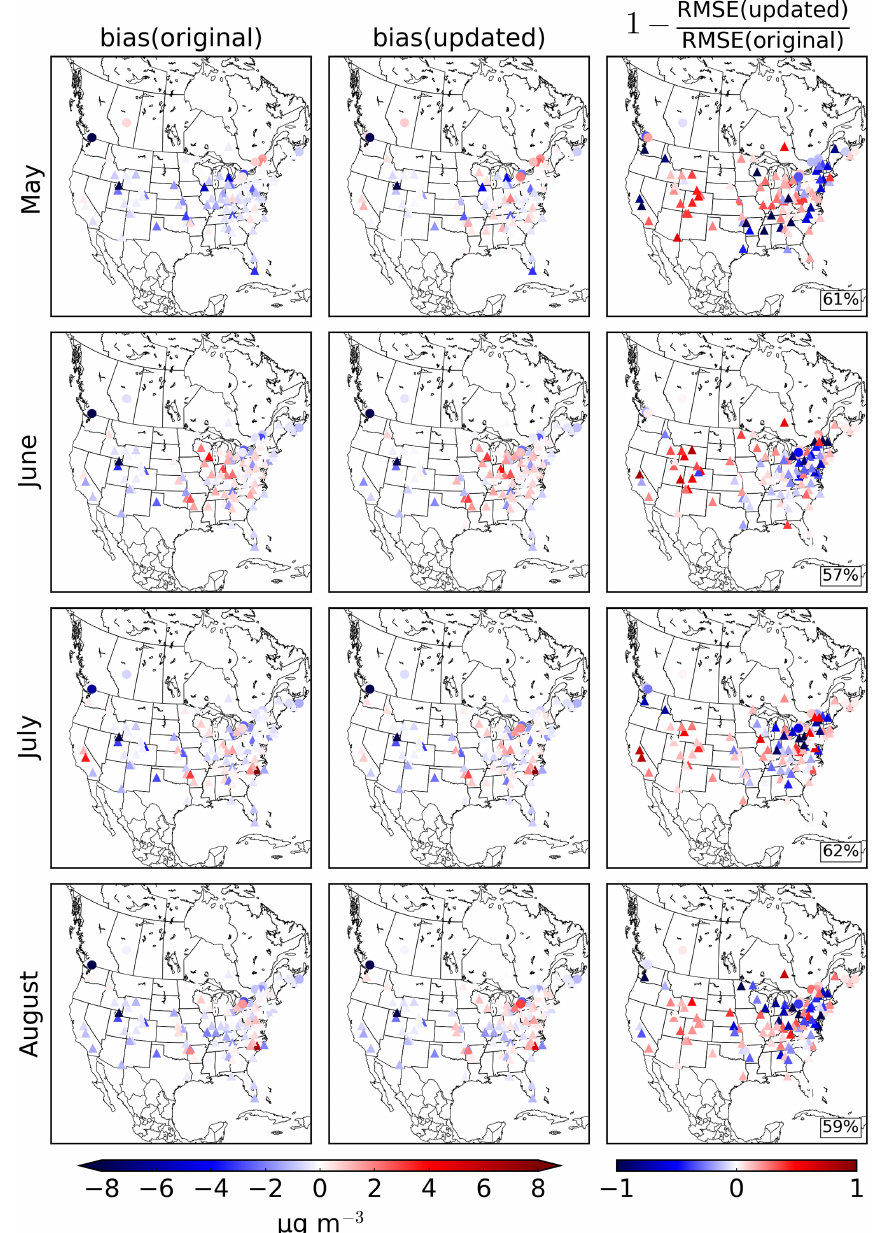
Figure 7. Comparison of ammonia surface observations from the NAPS and AMoN networks with GEM-MACH surface fields. The left and center columns show bias values for each station when the original and updated ammonia emissions are used, respectively. The right column shows the relative improvement of the root-mean-square error (RMSE) for each station. NAPS and AMoN stations are denoted with circular and triangular markers, respectively. For the plots in the right column, the percentage of stations that have a lower RMSE value when the updated ammonia emissions are used is shown in the lower right